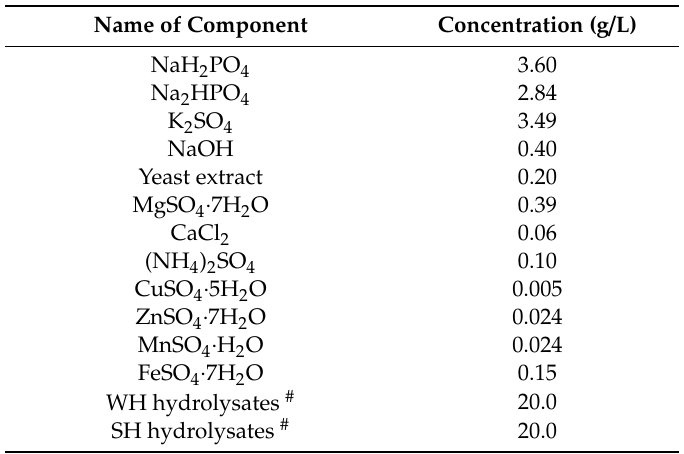
Table 1. Polyhydroxybutyrate (PHB) production media composition using water hyacinth (WH) hydrolysates and synthetic hydrolysates